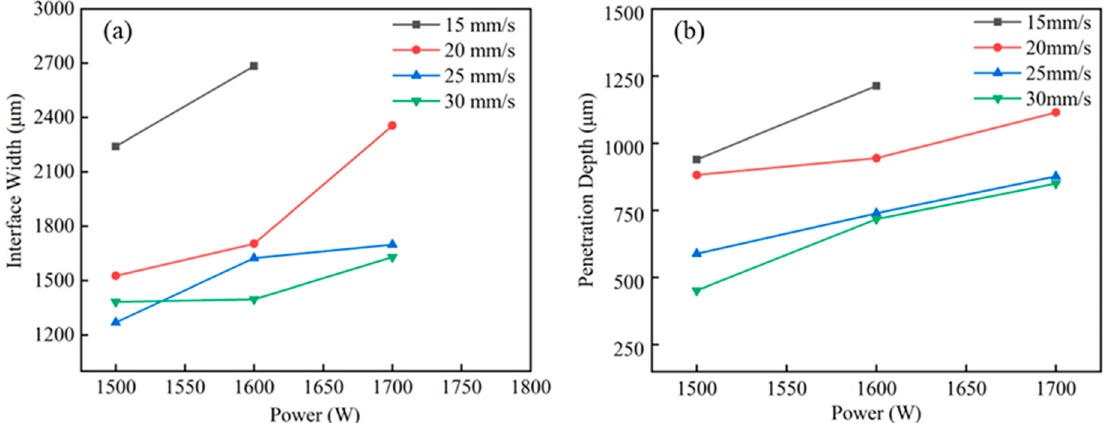
Figure 8. Interface width and penetration depth as a function of laser power: ( a ) interface width; ( b ) penetration depth.